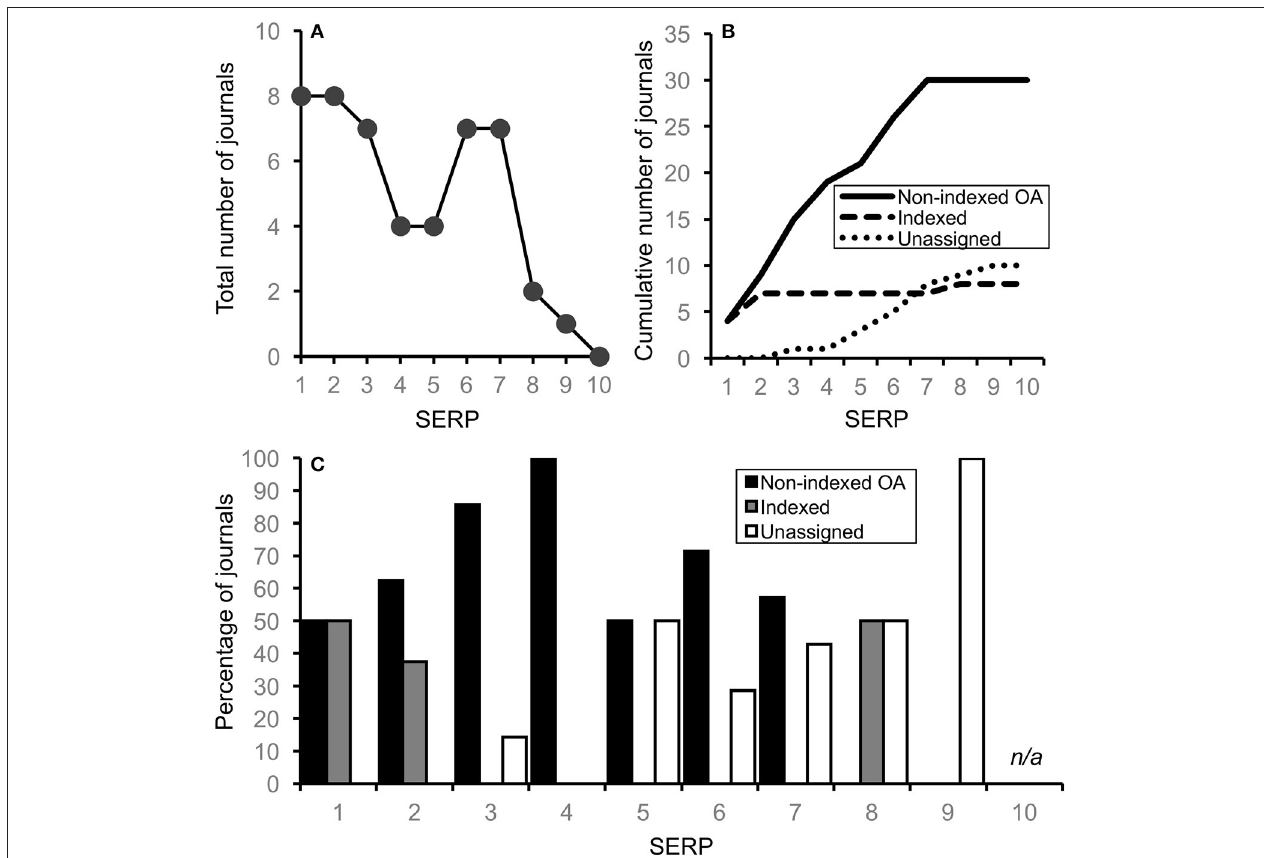
FIGURE 1 | (A) The total number of scientific journals ( n = 48) identified on each search engine results page (SERP; 10 hits page − 1 ). (B) The cumulative number of scientific journals identified in the Google search (across the 10 SERPs) that were categorized as non-indexed OA, indexed, or unassigned. (C) The percentage of journals identified on each SERP that were categorized as non-indexed OA (black), indexed (gray), and unassigned